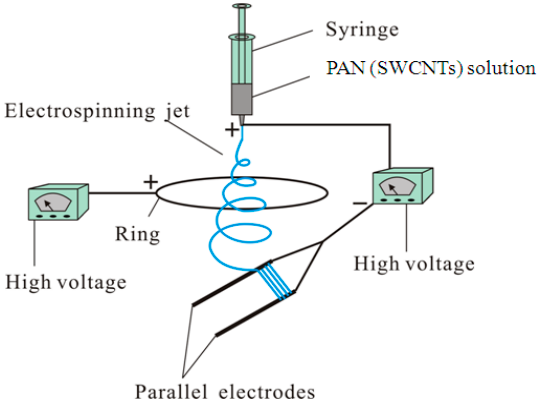
Figure 1. Schematic of the modified parallel electrode method (MPEM) apparatus.